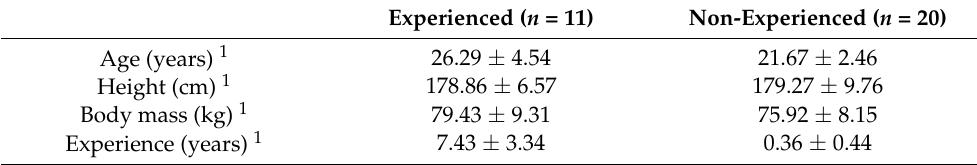
Table 1. Subject characteristics of the experienced and non-experienced groups of boxing